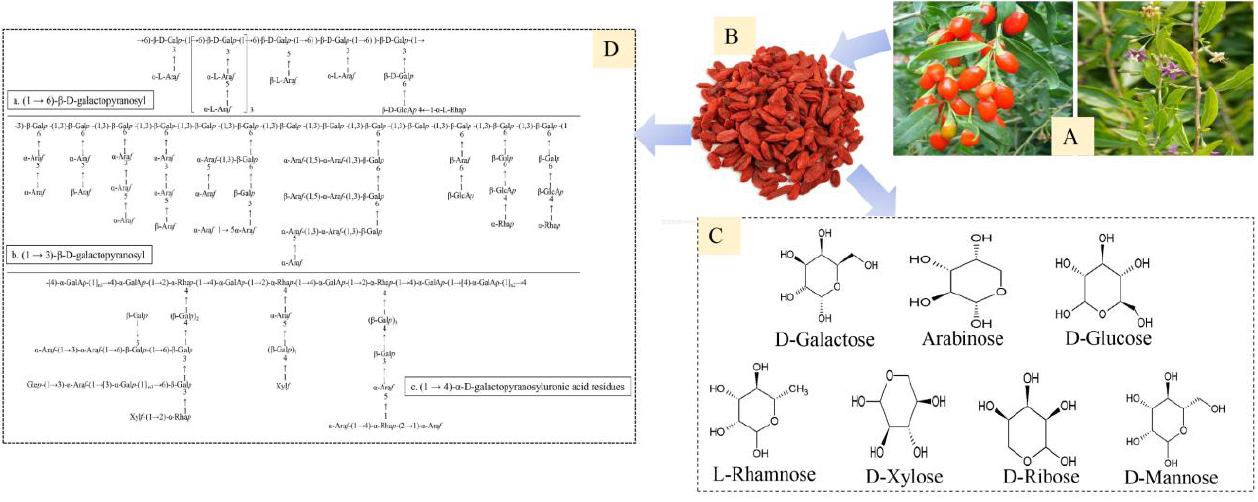
Figure 1. The characterization structure of LBPs. ( A) the fresh fruit of L. barbarum ; ( B) the dried fruit of L. barbarum ; ( C) the monosaccharide composition in LBPs; ( D) three representative struc- tures of LBPs, including (1 → 6)- β -D-pyranogalactosyl, (1 → 3)- β -D-pyranogalactosyl, and (1 → 4)- α -D- pyranogalactosyl